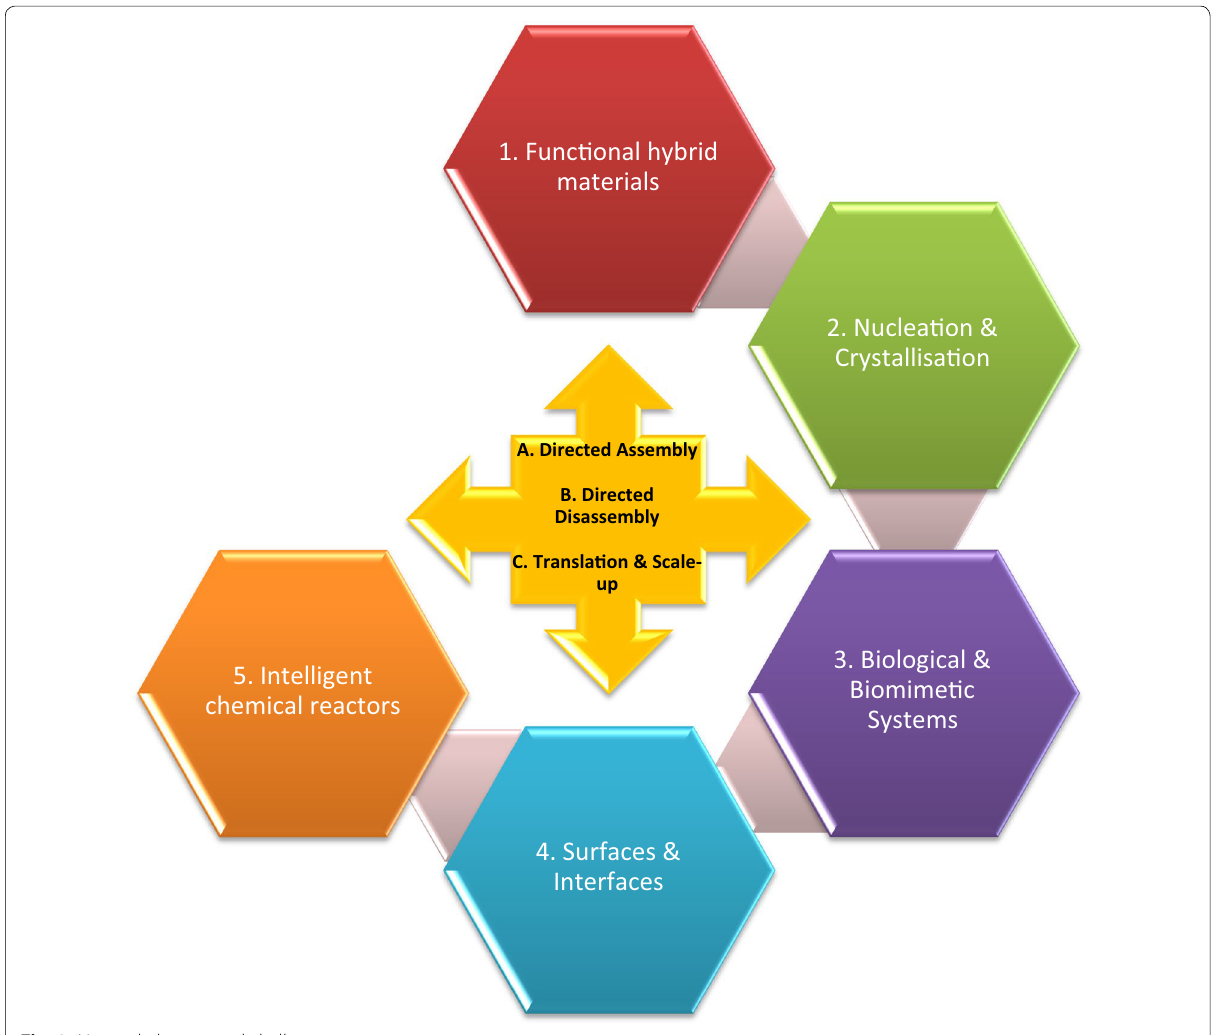
Fig. 3 Network themes and challenge